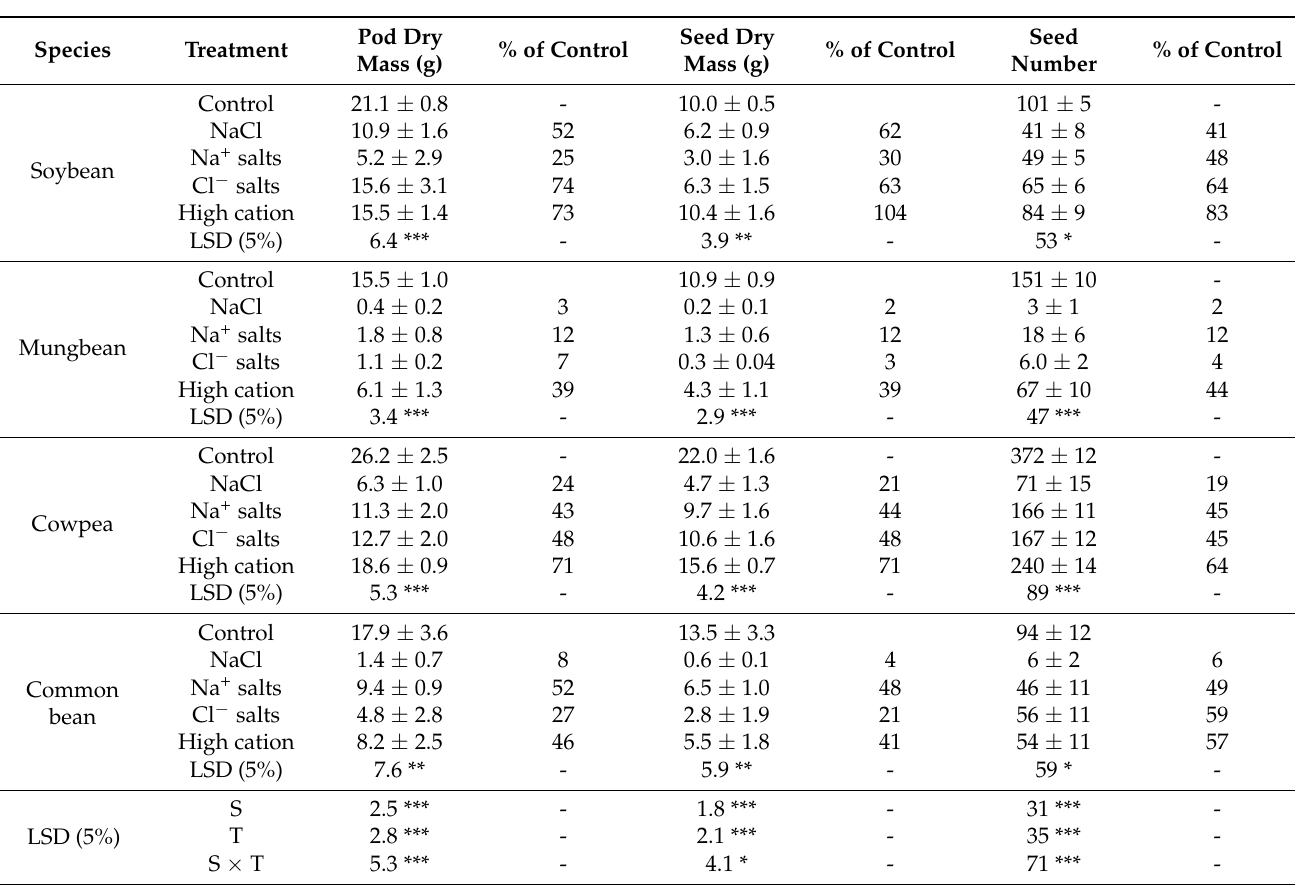
Table 2. Reproductive attributes of soybean, mungbean, cowpea, and common bean grown in control (non-saline), 100 mM NaCl, 100 mM Na + (without Cl − ), 100 mM Cl − (without Na + ), and high-cation negative control (K + , Mg 2+ , and Ca 2+ equivalent to those in the 100 mM Cl − treatment) treatments. The salts used in the various treatments are given in Table 1. Treatments were imposed on 13-day-old plants. The data are for mature pods (pod walls and seeds), mature seed dry mass, and the number of mature seeds per plant at 57 days. The values are means ± SE ( n = 4). The least significant differences (LSDs) for treatment means within each species, treatment, and species × treatment interaction are given at the bottom of each data column ( p = 0.05). The probability levels for two-way ANOVA were used to compare species (S), treatment (T), and species × treatment interaction (S × T) effects (* p < 0.05, ** p < 0.01, *** p < 0.001, and n.s. = not